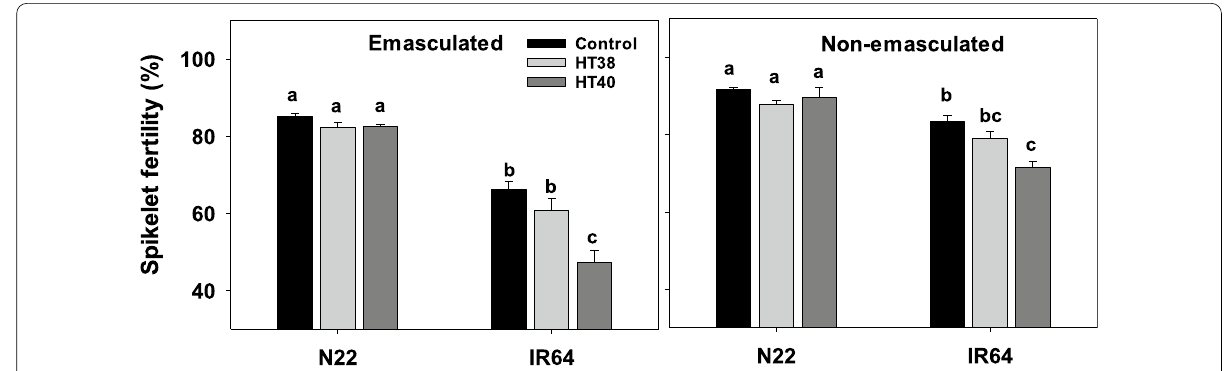
Fig. 1 Effects of control (30 °C) and heat stress (38 °C—HT38; 40 °C—HT40) exposure during gametogenesis on spikelet fertility in N22 and IR64. Emasculated – refers to spikelet fertility in panicles in which anthers were manually removed and pollinated by dusting fresh pollen. Non‑emasculated ‑ refers to spikelet fertility in panicles with natural pollination i.e., without manual interference. Values shown are mean standard error. Means followed by a common letter are not significantly different between temperature treatments and genotypes within either emasculated /non‑emasculated plants at P ≤